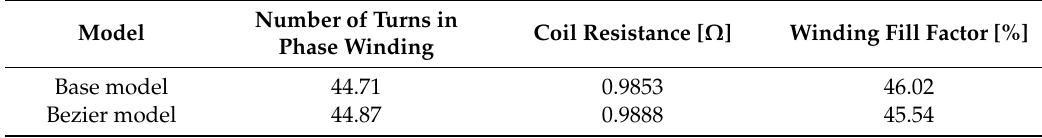
Table 1. Number of turns in phase winding, coil resistance, and winding fill factor for the base model and Bezier model.